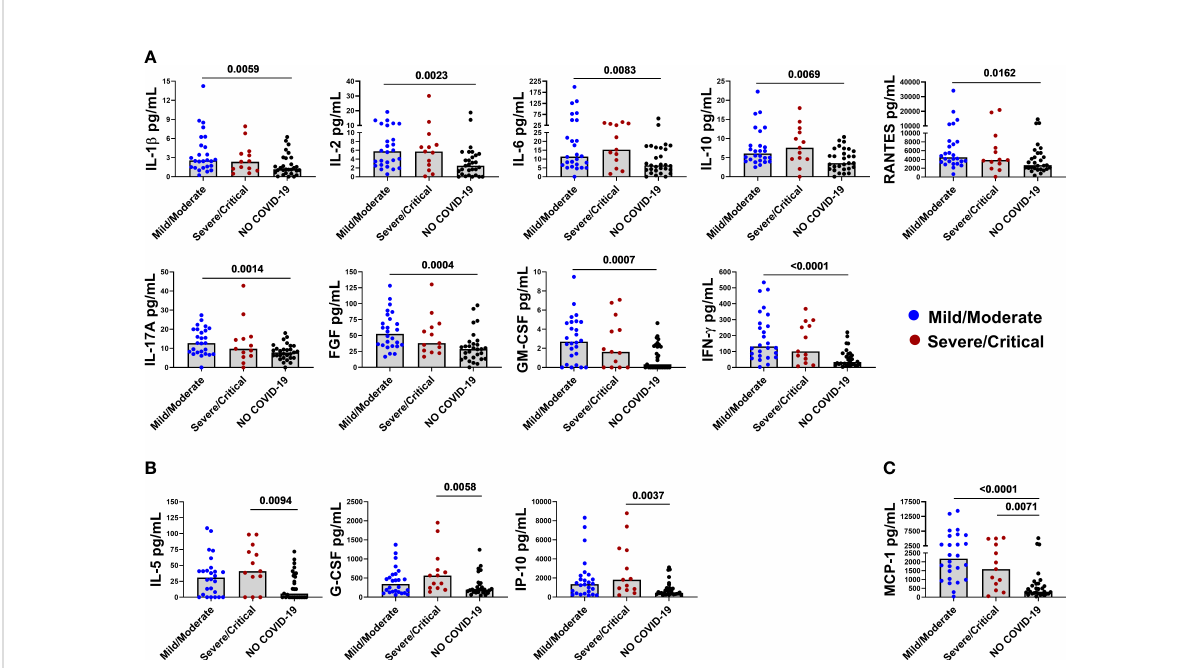
FIGURE 2 Baseline levels of elevated immune markers based on the disease severity. Panel (A) IL-1 b , IL-2, IL-6, IL-10, RANTES, IL-17A, FGF-basic, GM-CSF, and IFN- g are associated with mild/moderate disease. Panel (B) IL-5, G-CSF, and IP-10 are associated with severe/critical disease. Panel (C) MCP-1 is associated with both mild/moderate and severe/critical disease. After correction for multiple comparisons, p ≤ 0.016 was considered as signi fi